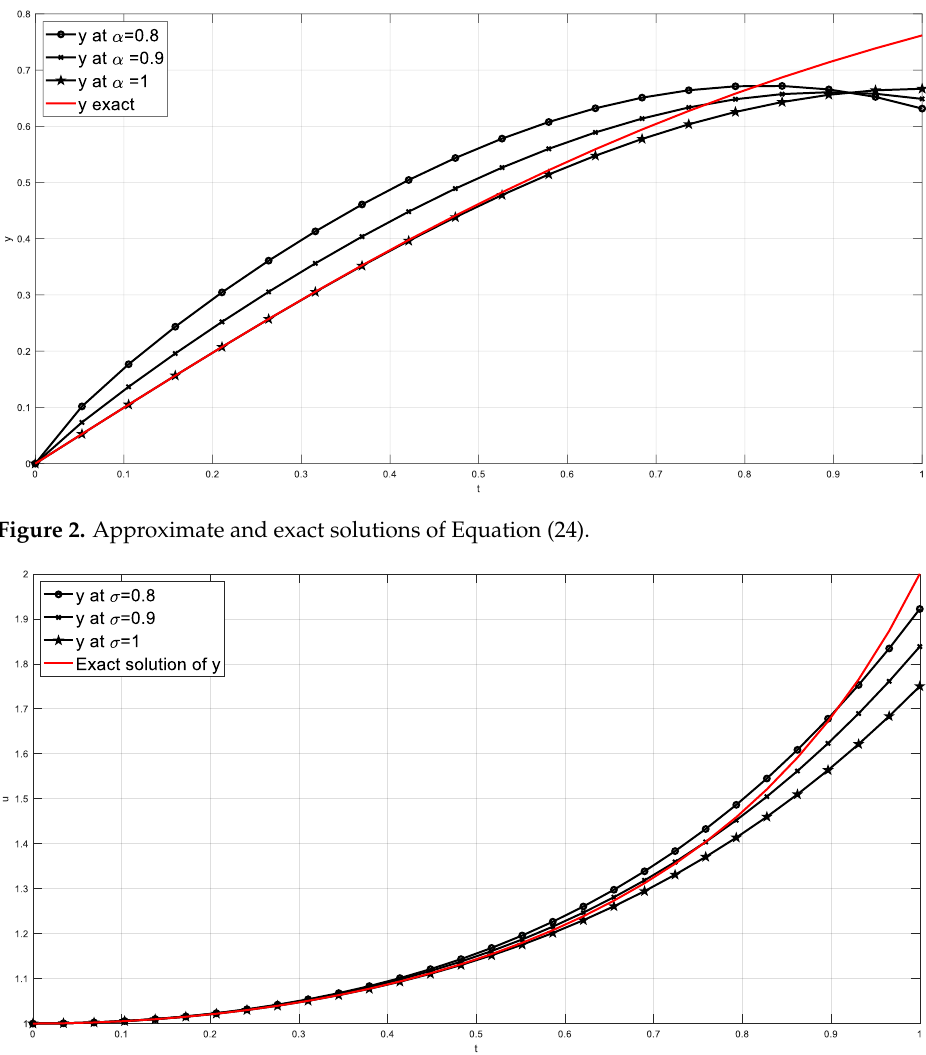
Figure 2. Approximate and exact solutions of Equation (24). Table 3. Values of the approximate and exact solutions of Equation (26) at different values of 𝓉 .